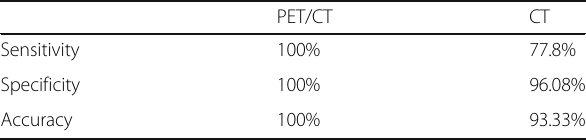
Table 4 Comparison between sensitivity, specificity, and accuracy of PET/CT and CT regarding local nodal metastasis detection